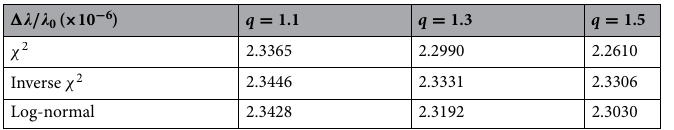
6 10 ) corresponding to the three universality classes of supertatistics, − × β 2 /β 2 0 ≡ � �